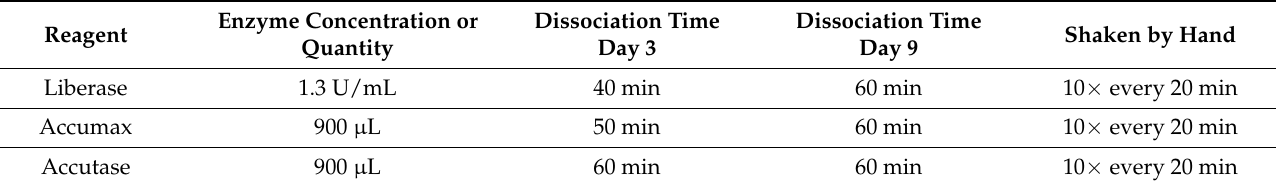
Table 3. Method for